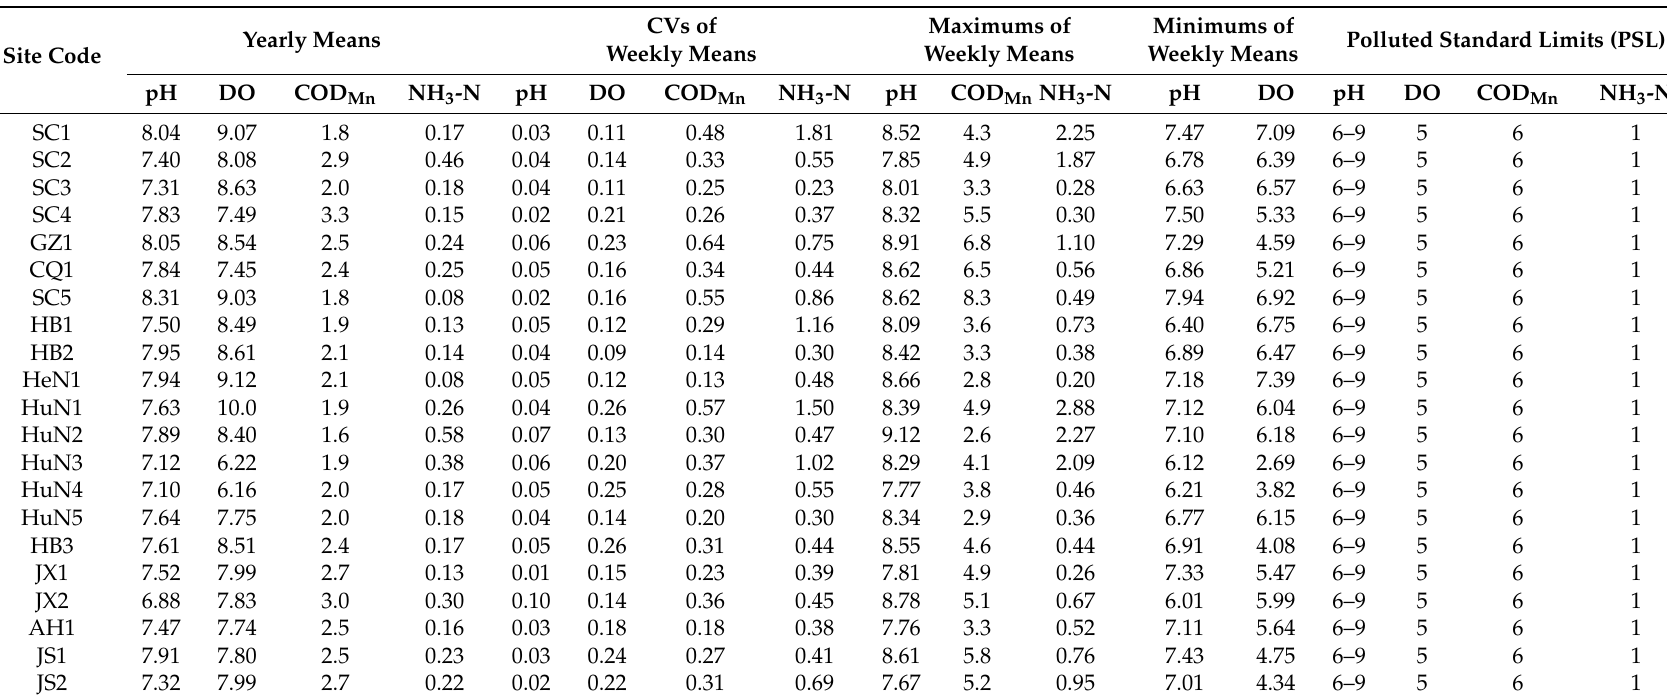
Table 4. Yearly means, CVs, and maximums and minimums of the weekly means and PSLs for pH, DO, COD Mn , and NH 3 –N at the 21 YRB sites in 2016.